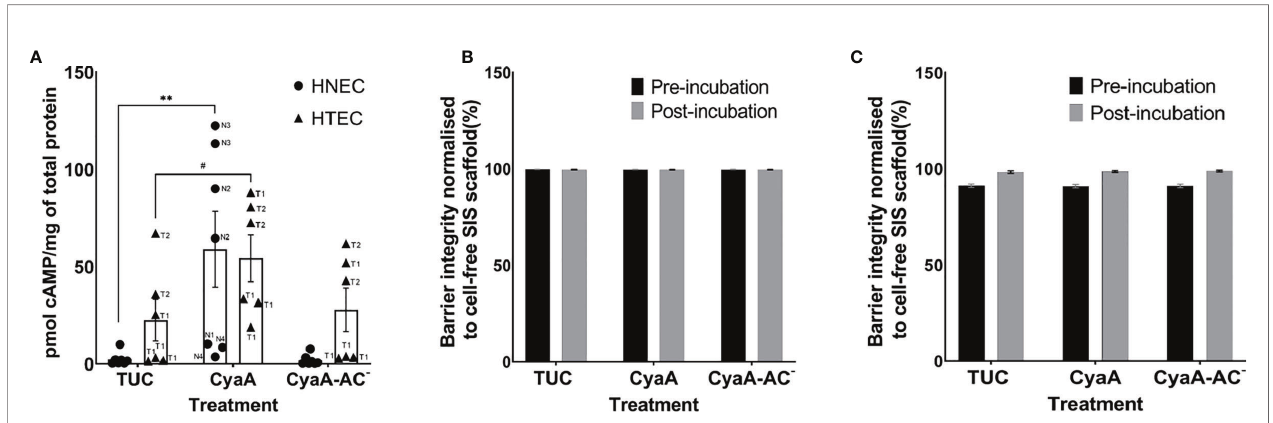
FIGURE 2 | CyaA affects intracellular cAMP level (A) , but not the epithelial barrier integrity of nasal (HNEC, B ) and tracheo-bronchial (HTEC, C ) airway mucosa tissue models. The samples in (A) were incubated with CyaA or its toxoid for 1 h and the samples in (B) for 24 h. Data in (A) are presented as means ± SEM (N=7 for HNEC, N=6 for HTEC). Each experiment was carried out in duplicates. **p value of Dunnett ’ s multiple comparison test (TUC vs. CyaA) ≤ 0.01, #p value of Dunnett ’ s multiple comparison test (TUC vs. CyaA) >0.05 ≤ 0.1 (trend). The graph also shows individual data points of independent experiments to analyze inter- and intra- donor variance. When no obvious inter- or intra-donor variance was observed, individual data points were not labeled. Data in (B, C) are presented as means ± SEM of four independent experiments performed in duplicates (N=4).